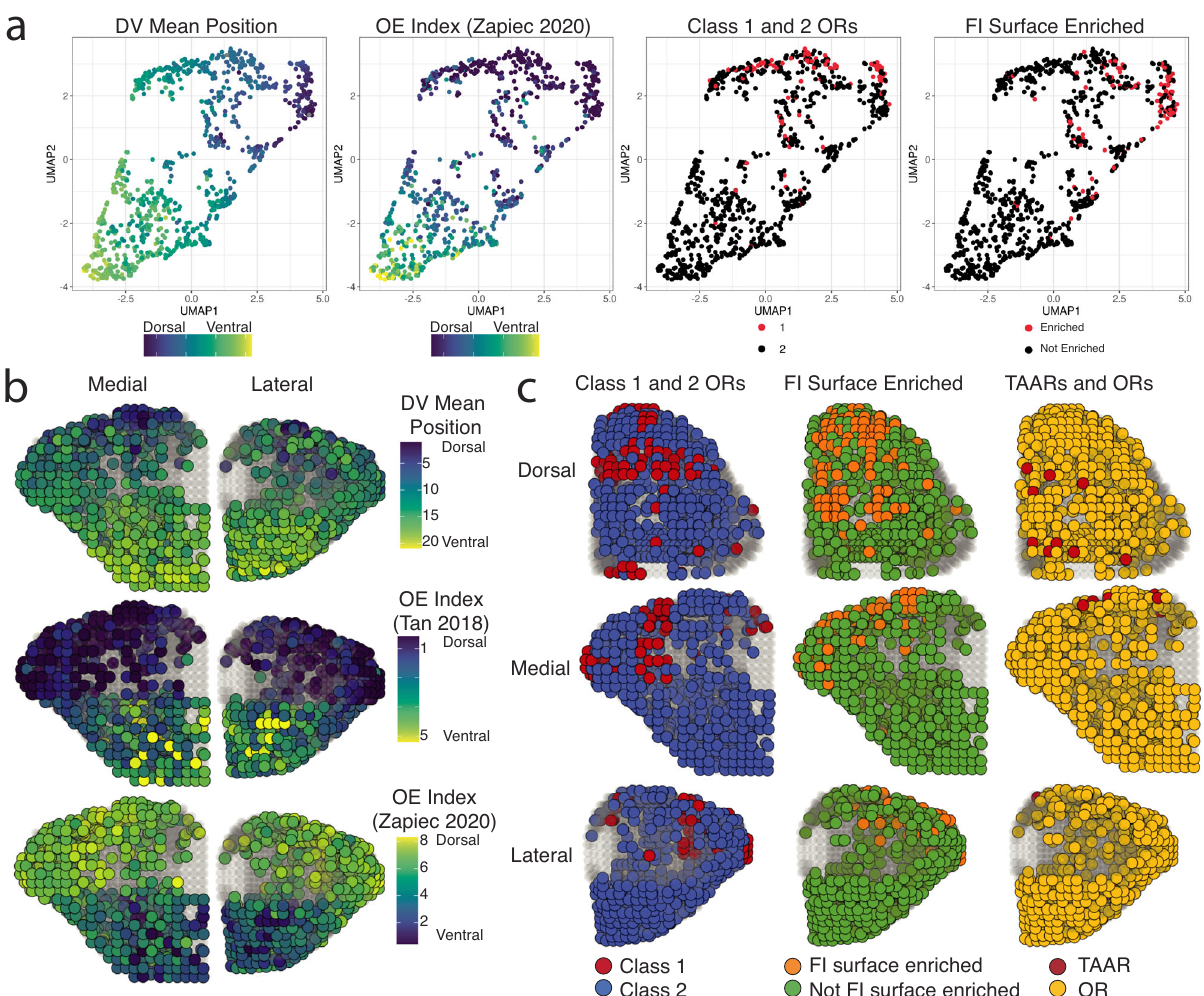
Fig.6|Athree-dimensionalmodelforORglomerularpositionsfromcombined single-dimensiontargetedsequencingdata.a UMAPprojectionsofORtranscript populations constructed using the mean transcript position from each individual replicate fromthe AP, DV,and ML dimensions. DV mean position color re fl ects the calculated average mean position from all DV replicates. OE Index (Zapiec 2020) refers to the OE index established by Zapiec and Mombaerts Cell Reports 2020. FI Surface refers to the differential expression analysis calculated from dorsal and